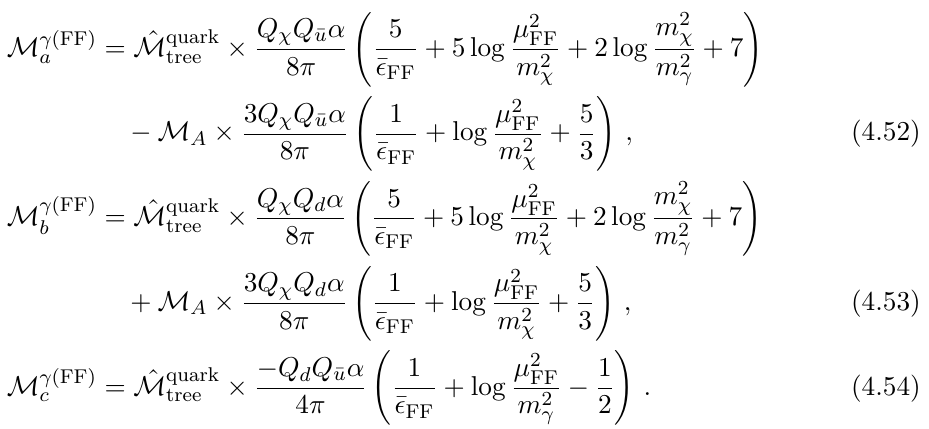
contribute to the charged Wino decay